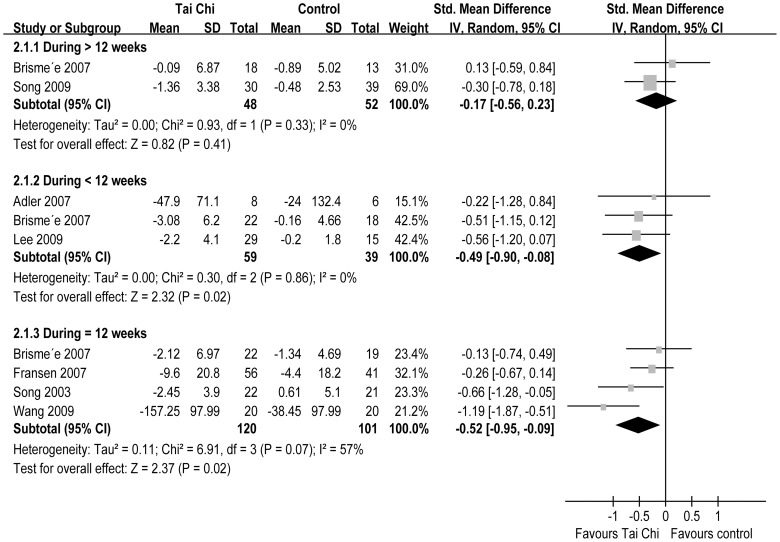
A Forest plot of the subgroup analyses of RCTs comparing Tai Chi group with control group for change in pain.